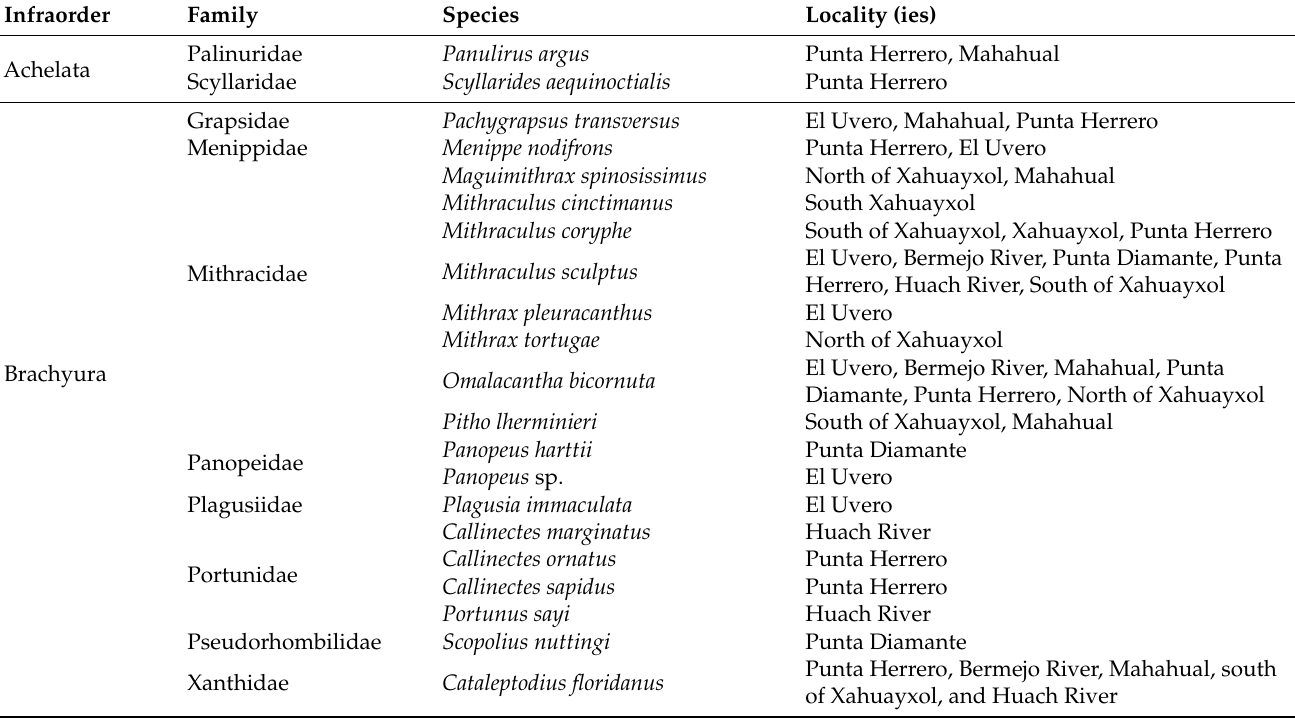
Table 2. Taxa of decapods (Achelata and Brachyura) recorded in this work and localities where they were